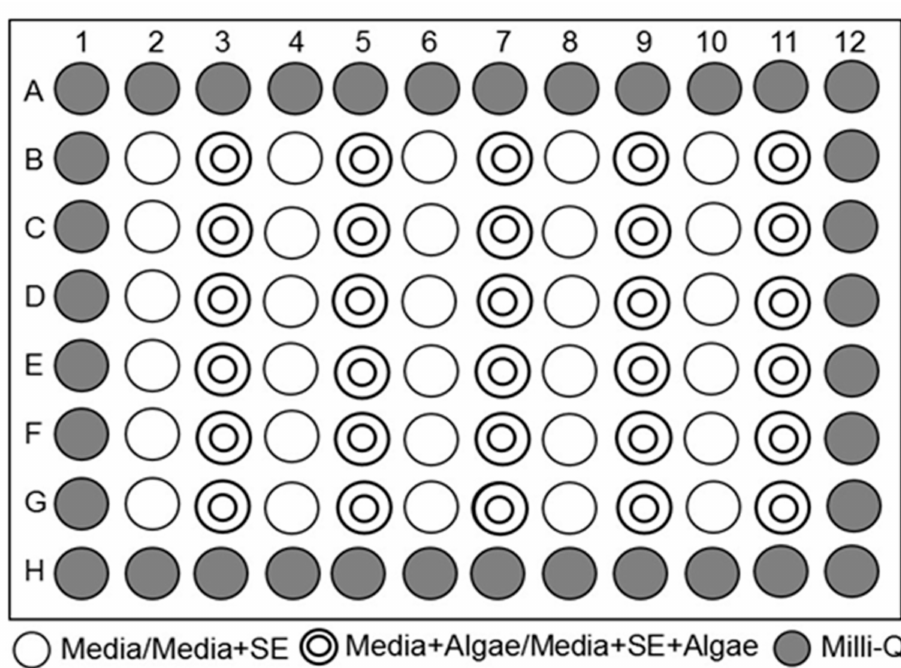
Figure 10. Microplate-incubation